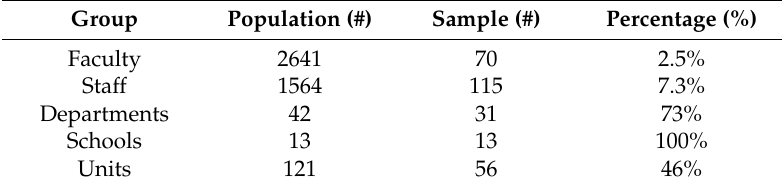
Table 2. Population size and sample size and proportion in organizational